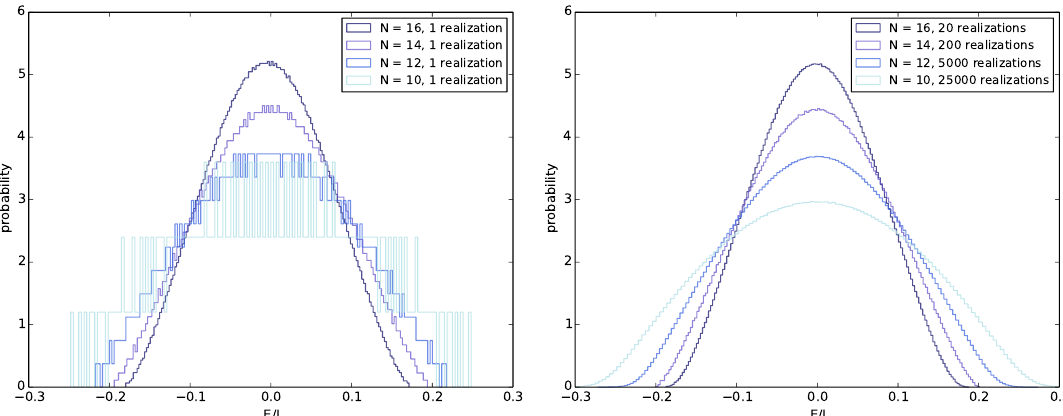
Figure 7 . Unit normalized histogram of energy eigenvalues (in units of J ) in the SYK model for N = 10 ; 12 ; 14 ; 16 sites. This converges to the continuum probability density (cid:26) ( E ). Left panel : spectrum for a single realization. Right panel : spectrum averaged over disorder realizations. We see that already for N = 16 the spectrum for a single realization is essentially indistinguishable from the ensemble